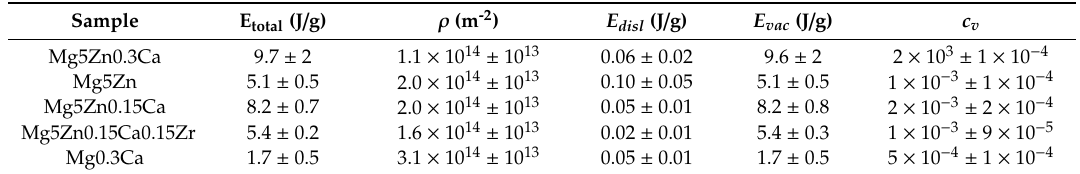
Table 6. Measured and calculated data for DSC peak I. ρ is the dislocation density, c v the vacancy concentration.